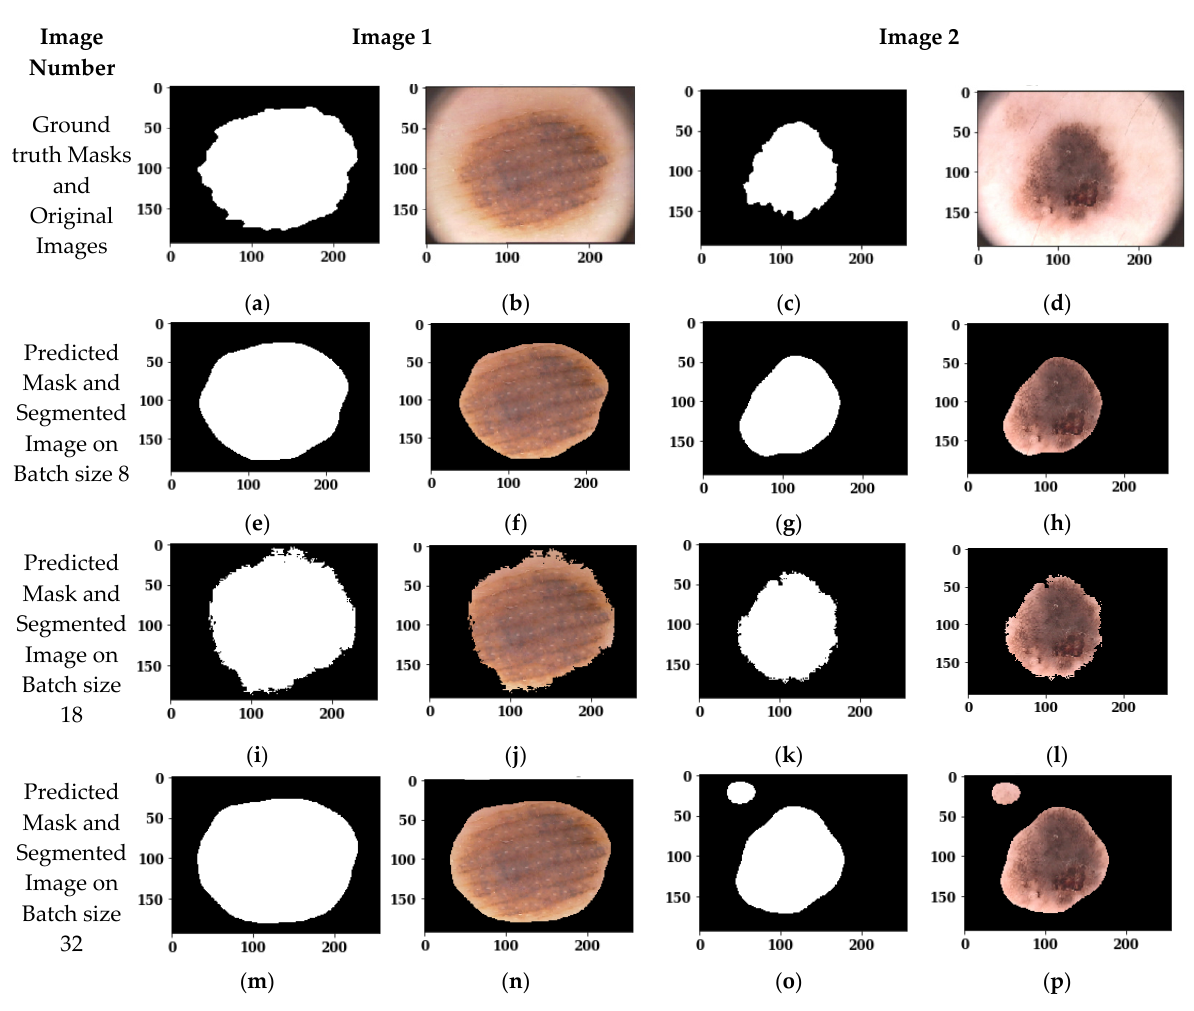
Figure 9. Images segmented on the Adam Optimizer, 100 epochs and different batch sizes: ( a ) Ground truth Mask of Original Image 1; ( b ) Original Image 1; ( c ) Ground truth Mask of Original Image 2; ( d ) Original Image 2; ( e ) Predicted Mask of Image 1 on batch size 8; ( f ) Segmented Output of Image 1 on batch size; ( g ) Predicted Mask of Image 2 on batch size 8; ( h ) Segmented Output of Image 2 on batch size 8; ( i ) Predicted Mask of Image 1 on batch size 18; ( j ) Segmented Output of Image 1 on batch size 18; ( k ) Predicted Mask of Image 2 on batch size 18; ( l ) Segmented Output of Image 2 on batch size 18; ( m ) Predicted Mask of Image 1 on batch size 32; ( n ) Segmented Output of Image 1 on batch size 32; ( o ) Predicted Mask of Image 2 on batch size 32; ( p ) Segmented Output of Image 2 on batch size